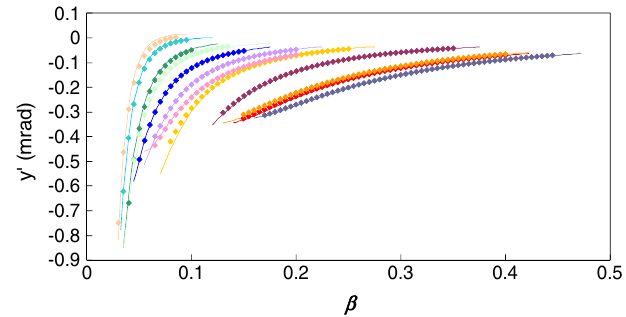
FIG. 6. On-axis steering vs (cid:1) in the 12 INFN-TRIUMF type from 0.043 to 0.25, at 1 MV = m , QWRs of Fig. 2 with (cid:1) o A=q ¼ 1 , and (cid:2) ¼ (cid:1) 30 (cid:6) , calculated with particle tracking (diamonds) and by means of expression (11) (lines), in the range to 2 (cid:1) . from 0 : 75 (cid:1) o o